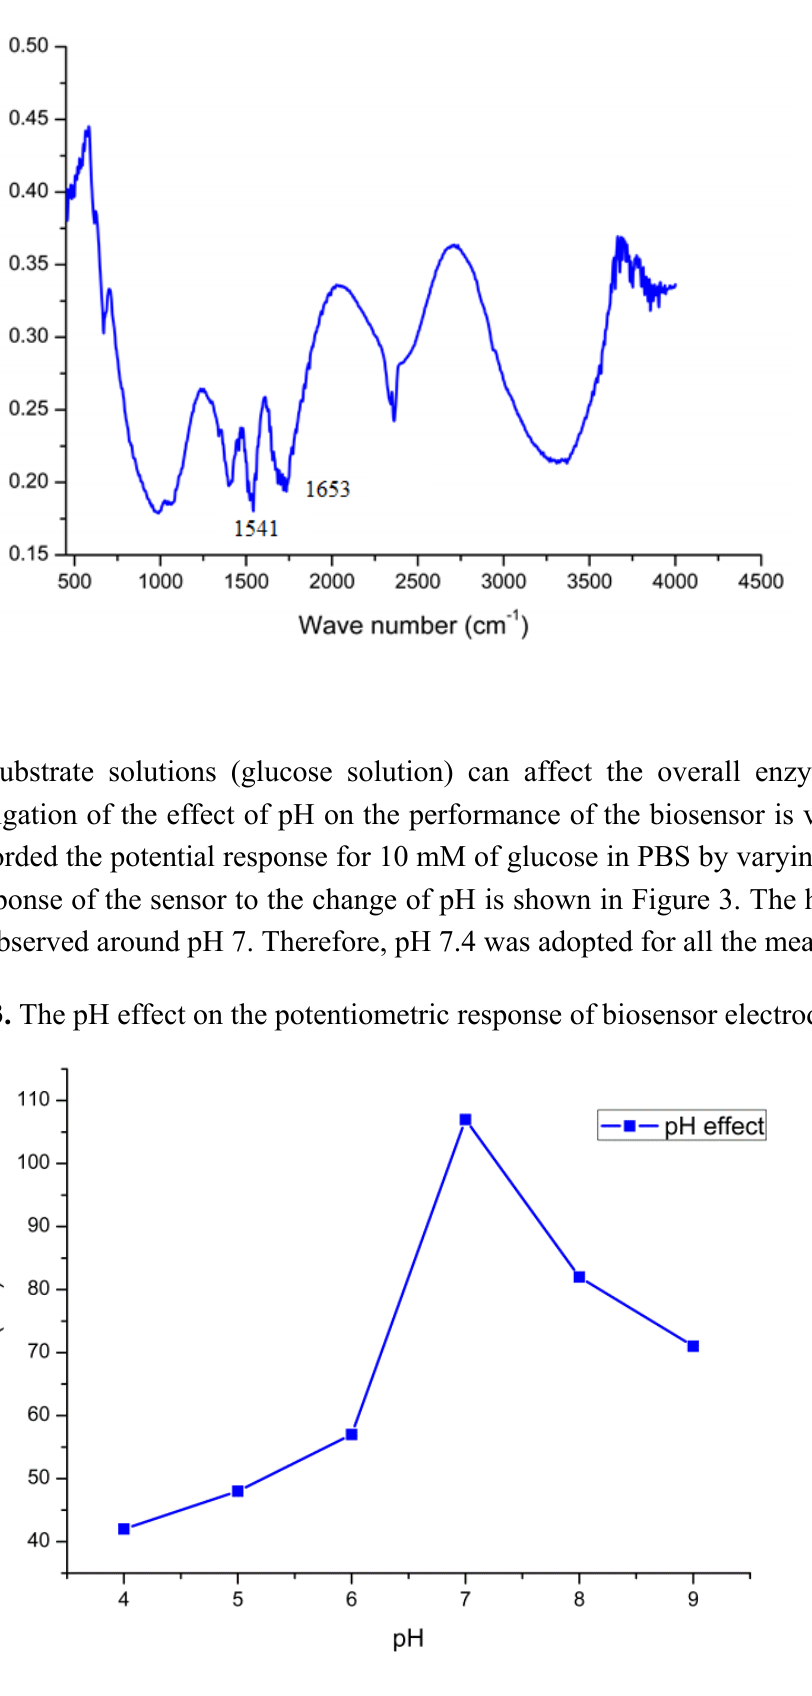
Figure 2. Fourier transform infrared (FTIR) spectrum of glucose oxidase immobilized on the ZnO-NRs.